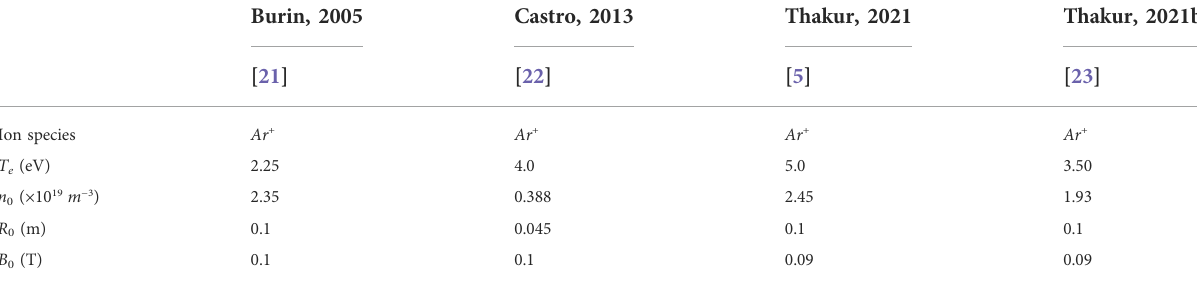
TABLE 2 Experimental parameters obtained for the validation data sets of Figure 3, used for the validation of Ahedo ’ s radial model in the magnetized case [20, 12], as shown in Eqs 4 – 6.